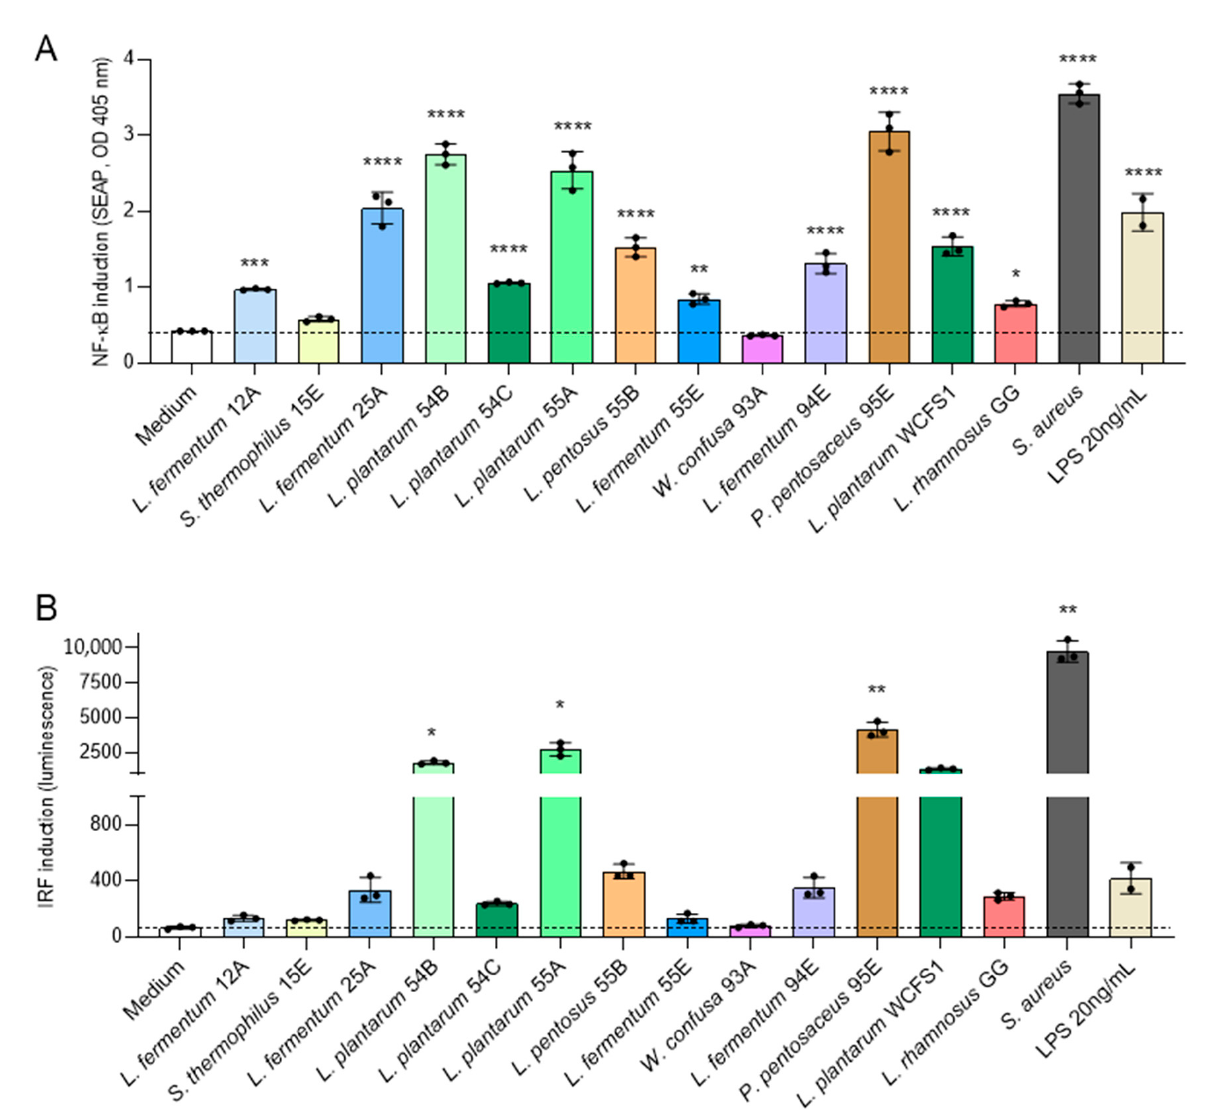
Figure 4. Immunostimulatory ( A ) NF- κ B and ( B ) IRF activation by LAB strains in THP1-Dual human monocytes. S. aureus MI/1310/1938 was used as a Gram-positive pathogenic control strain. Bars depict mean ± SD per condition ( n = 3). * p < 0.05, ** p < 0.01, *** p < 0.001, **** p < 0.0001 compared to medium control without bacteria (indicated by dotted line); L. plantarum , Lactiplantibacillus plantarum ; L. pentosus , Lactiplantibacillus pentosus ; L. fermentum , Limosilactobacillus fermentum ; P. pentosaceus